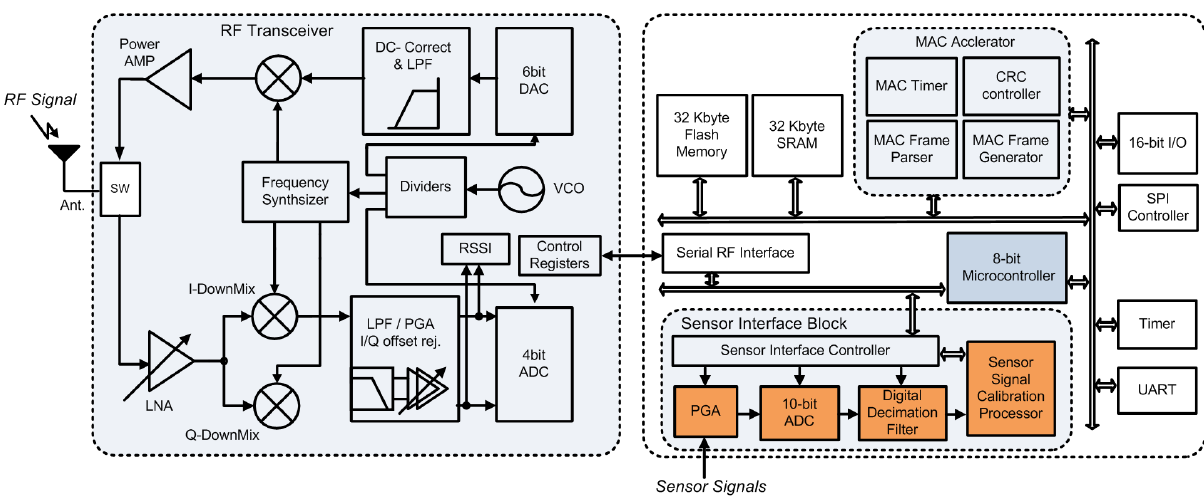
Figure 1. Architecture of a fully integrated sensor